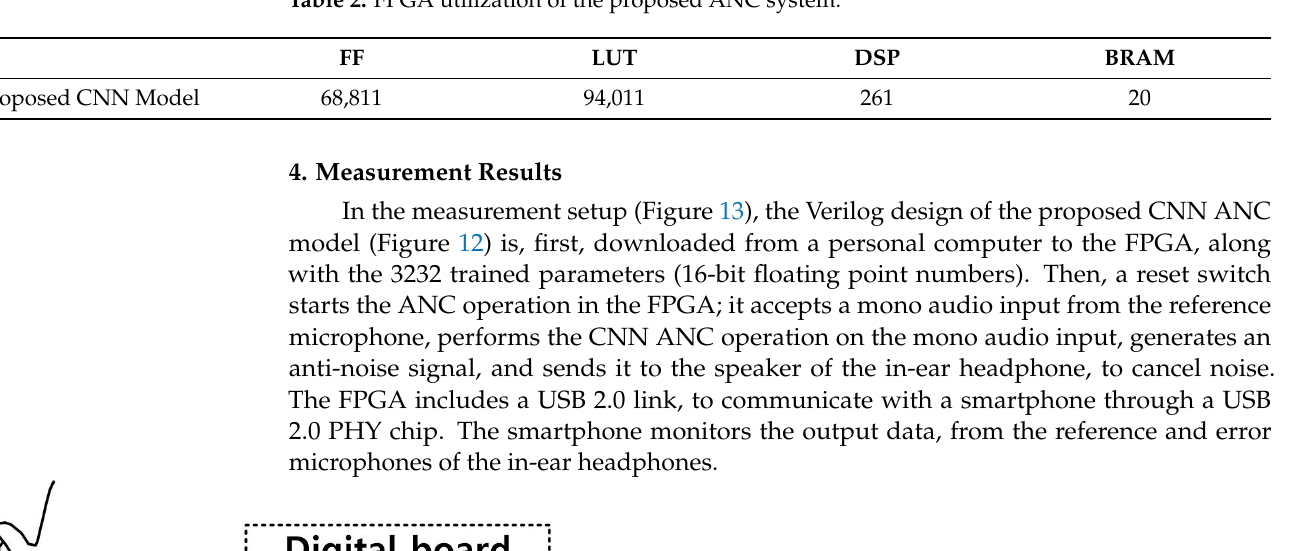
Table 2. FPGA utilization of the proposed ANC system.